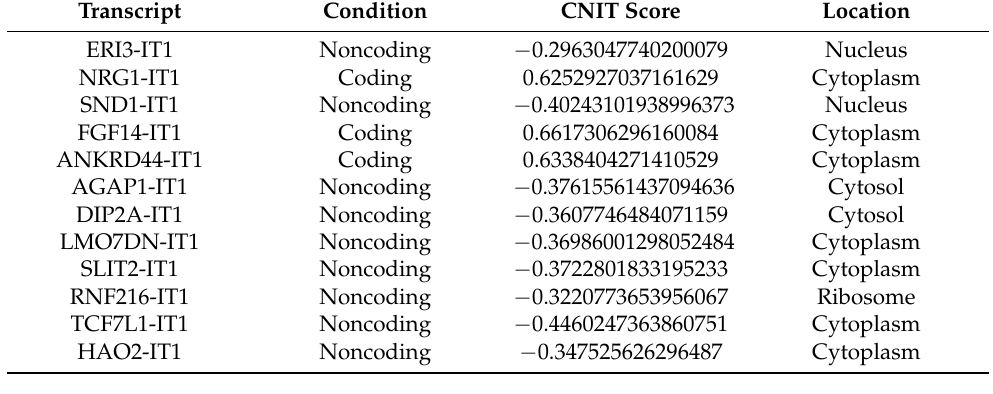
Table 3. The list of differentially expressed intronic transcripts with their condition, CNIT score and their location in a cell.